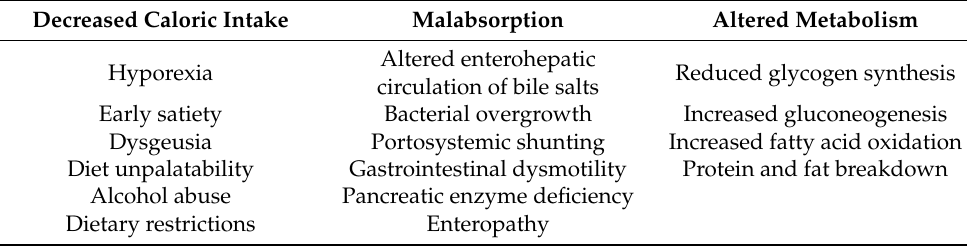
Table 1. Pathogenesis of malnutrition in